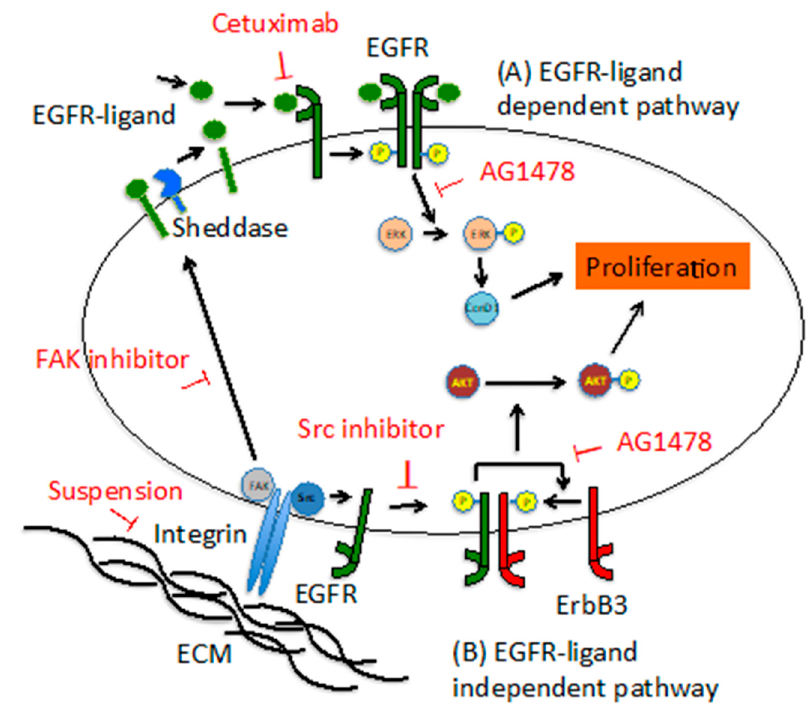
Figure 9. Models of EGFR-ligand dependent pathway and EGFR-ligand independent pathway in EIS cells. ( A ) In the EGFR-ligand dependent pathway, proliferation is promoted via ERK / cyclin D1 by EGFR activated by the binding of an EGFR-ligand and EGFR. The activity of FAK or sheddase may be involved in EGFR phosphorylation. ( B ) In the EGFR-ligand independent pathway, EGFR transactivated via Src by cell-substratum adhesion phosphorylates ErbB3 and promotes proliferation via AKT.